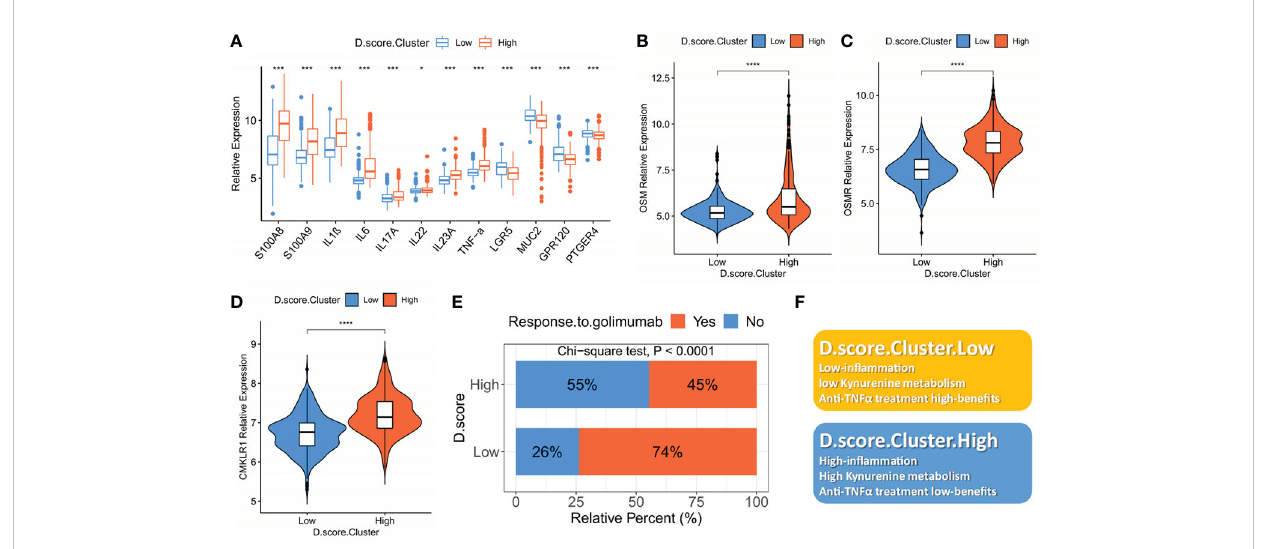
FIGURE 5 The role of the D. score in assessing intestinal in fl ammation and predicting anti-TNF-alpha bene fi ts. (A) The mRNA expression levels of intestinal in fl ammatory markers (S100A8, S100A9, TNF- a , IL-1B, IL-6, IL-17, IL-22, INF- g ) and barrier function markers (LGR5, MUC2) in high D. score versus low D. score subgroups. (B) , (C) and (D) The mRNA expression levels of anti-TNF-alpha-resistant biomarkers (CMKLR1, OSM and OSMR) in high D. score versus low D. score subgroups. The asterisks represented the statistical P-value (*P < 0.01; ***P < 0.001; ****P < 0.0001). (E) The fraction of patients with clinical response to anti-TNF-alpha immunotherapy (golimumab) in low or high D. score groups (Chi-square test; p<0.0001). (F) Summary diagram of the biological characteristics in low or high D. score